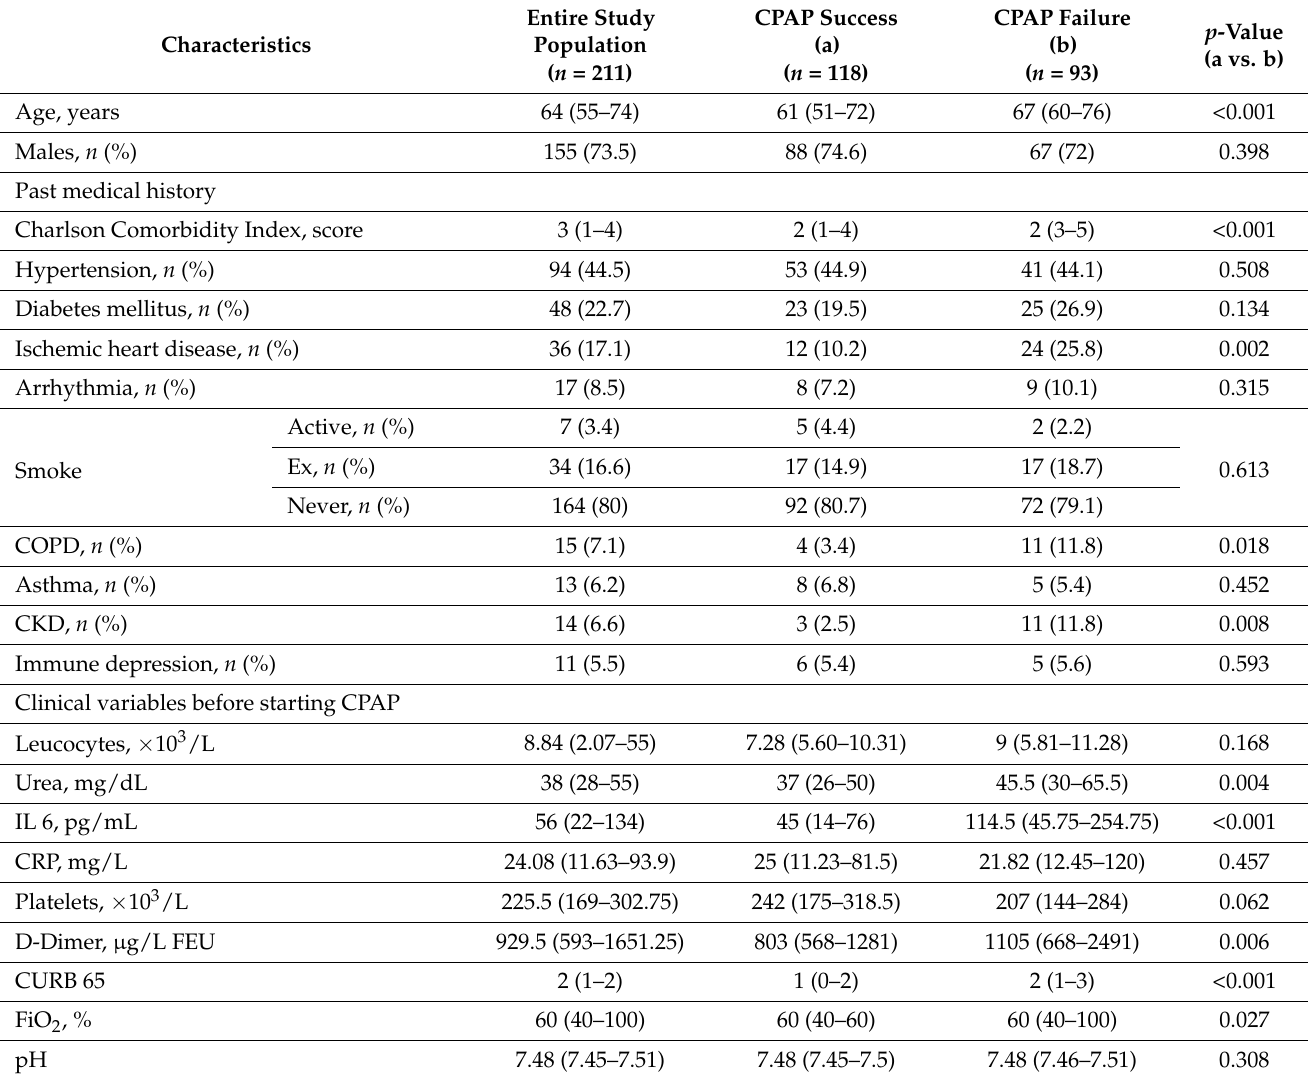
Table 1. Clinical and gas exchange characteristics before and after CPAP positioning in the whole study population and in patients that succeeded or failed respiratory support with CPAP.